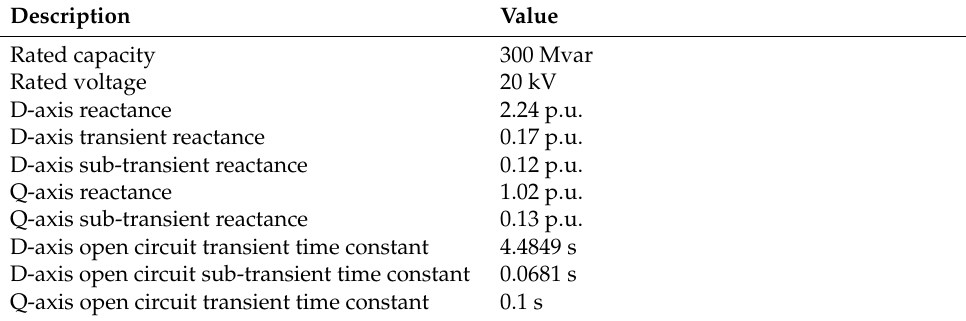
Table 2. Parameters of the new-type synchronous